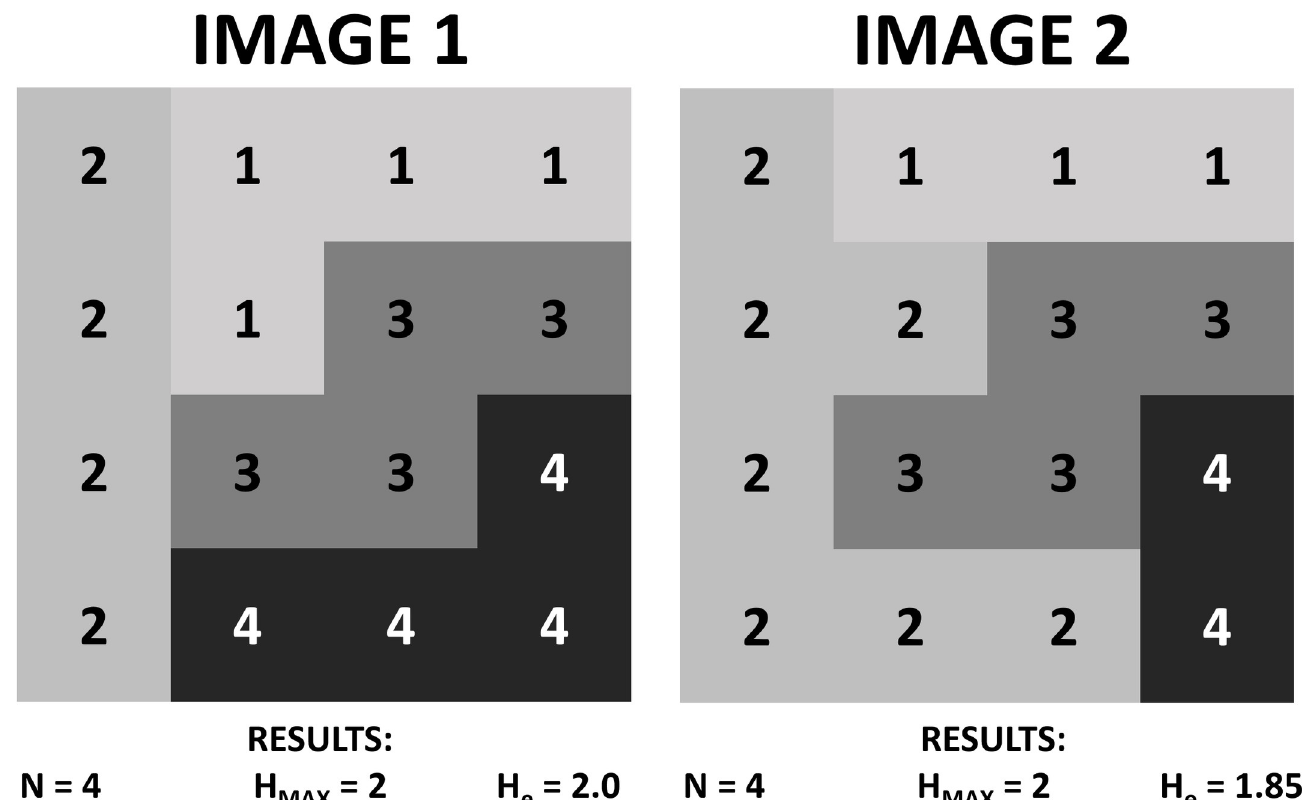
Fig 3. Maximum entropy (H max ) and entropy (H e ) results for hypothetical images with the same system extension (N), but different frequencies for some digital numbers